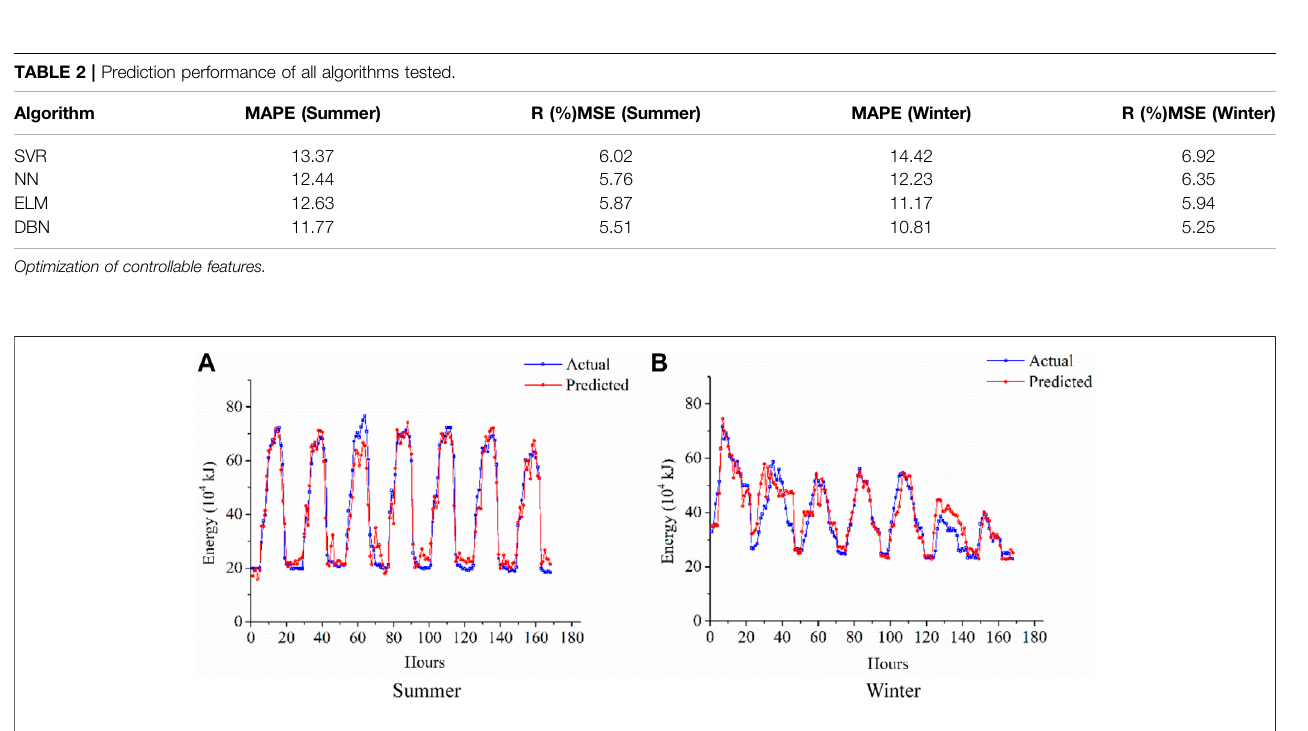
FIGURE 6 | Prediction performance of the testing dataset in Summer and